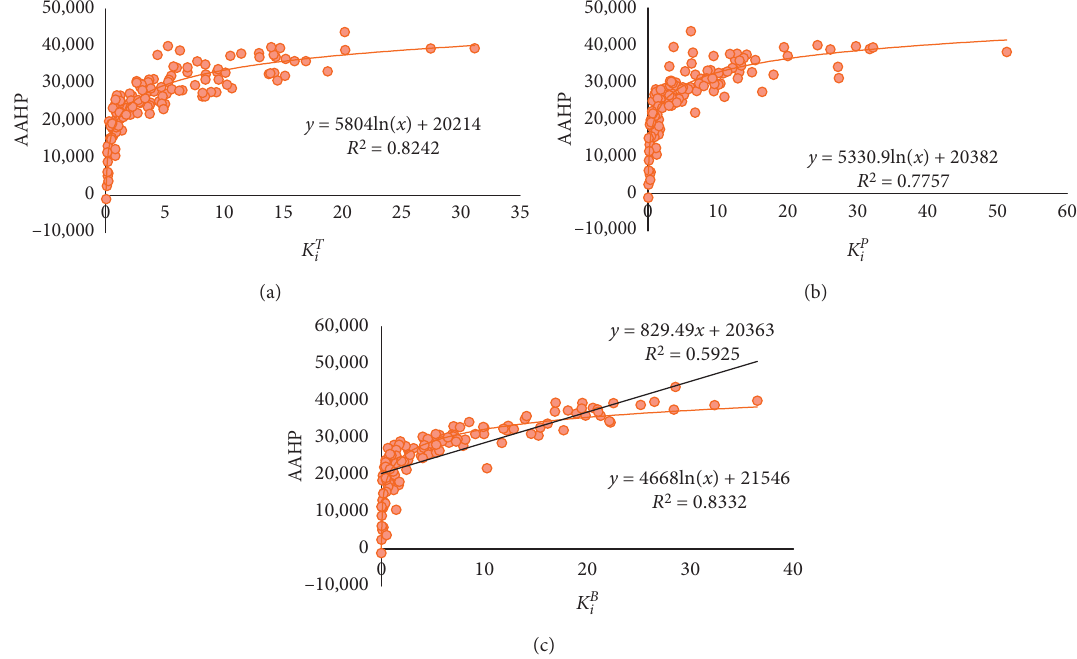
K P K B i , i , and i . (a) Transportation accessibility. (b) Public service intensity. (c) Commercial service intensity.